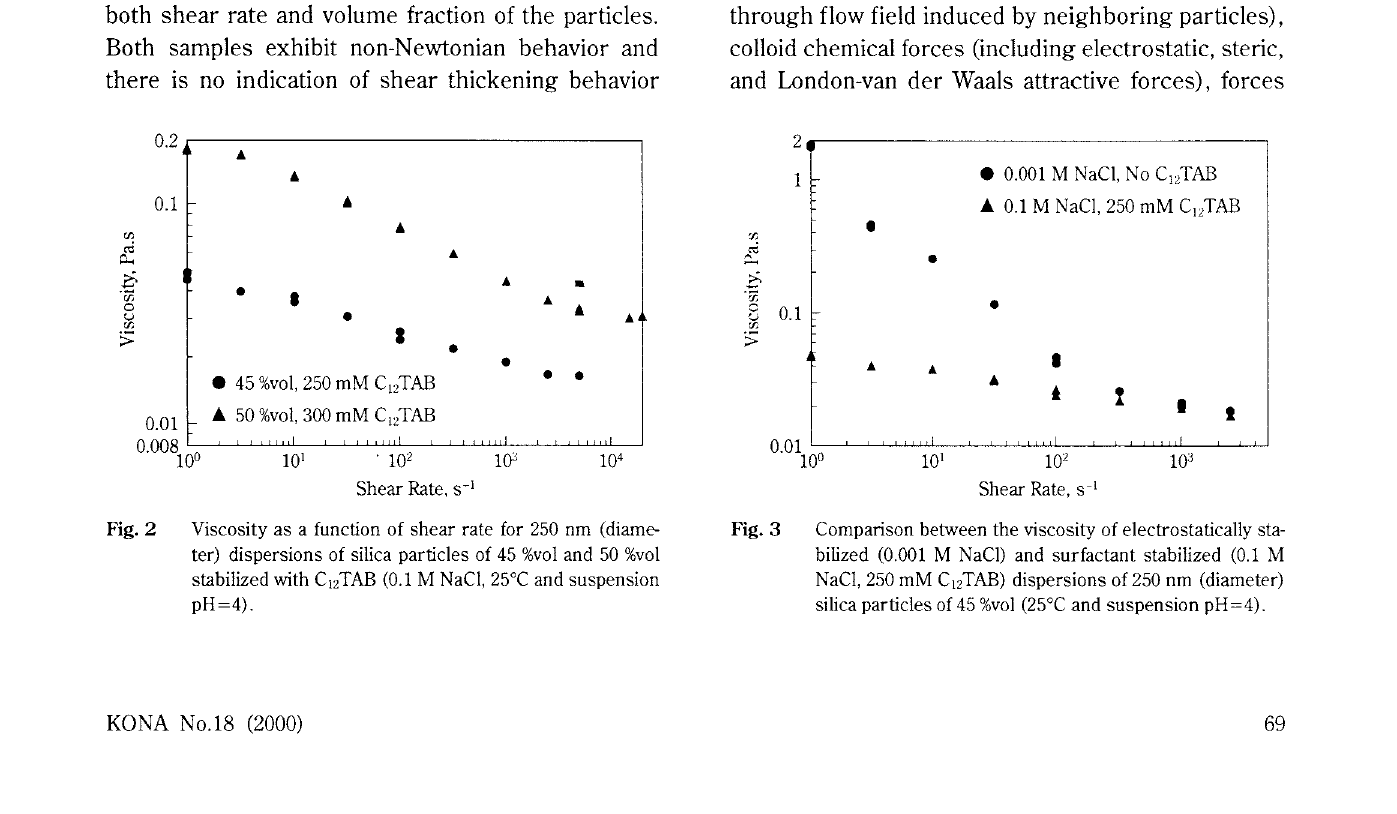
Comparison between the viscosity of electrostatically sta bilized (0.001 M NaCI) and surfactant stabilized (0.1 M NaCI, 250 mM C 12 TAB) dispersions of 250 nm (diameter) silica particles of 45 %vol (25°C and suspension